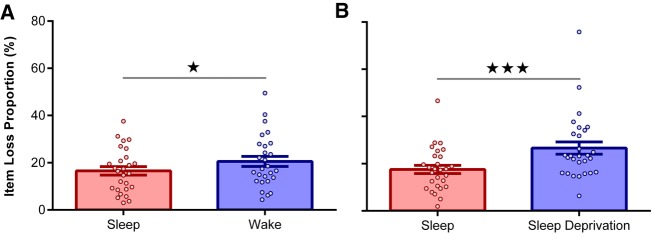
Item forgetting. (A) Experiment 1: Item forgetting was greater after a day of wakefulness relative to a night of sleep. (B) Experiment 2: Item forgetting was also greater after overnight sleep deprivation relative to sleep. Data points represent individual participants. Data are shown as mean ± SEM. (★) P < 0.05; (★★★) P < 0.001.